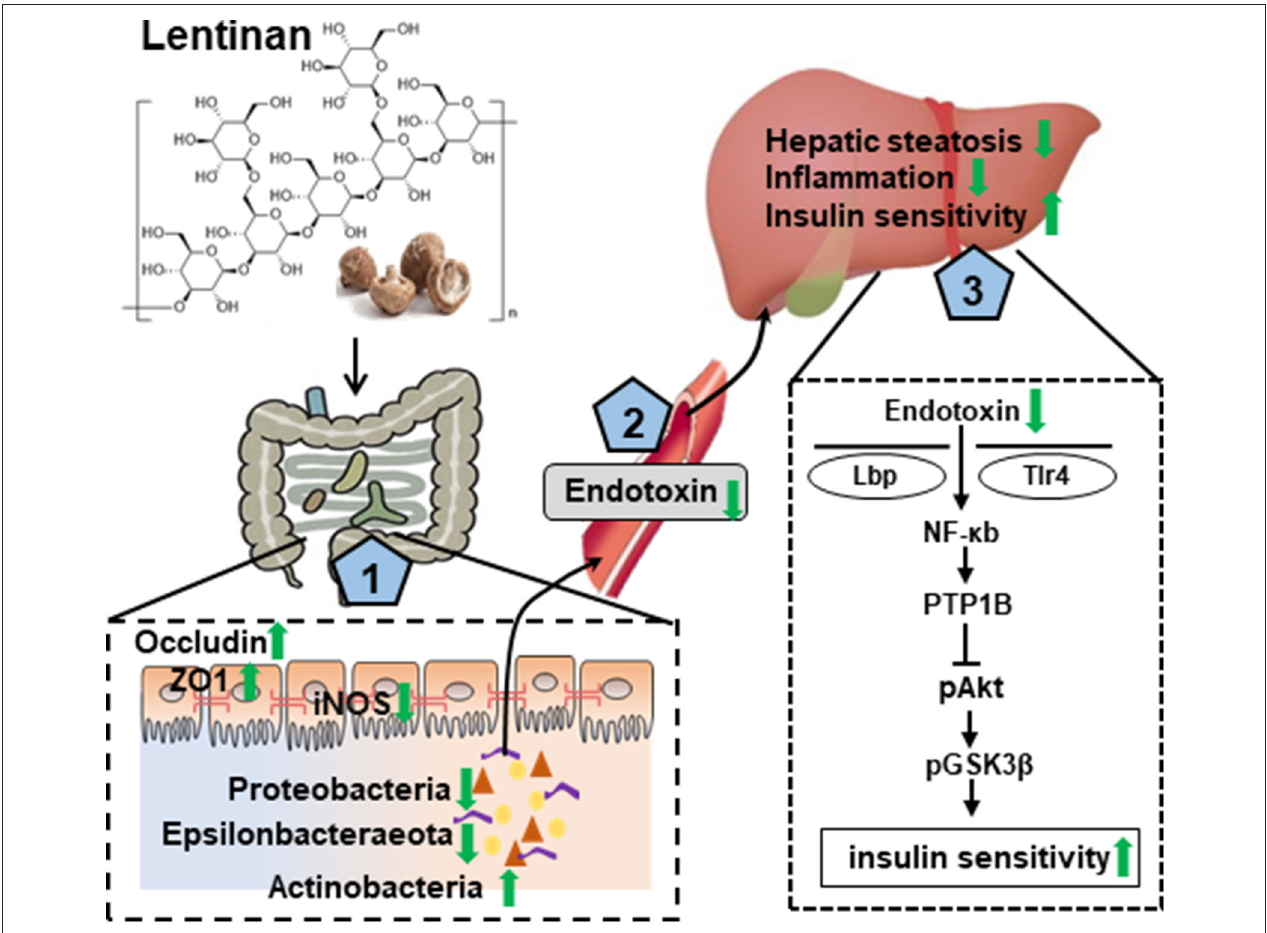
FIGURE 7 | Graphical summary of the protective effect of lentinan on the development of NAFLD via the gut–liver axis. Lentinan showed conservation of appropriate intestinal microbiota composition, resetting cellular redox balance (activation of antioxidants and inhibition of iNOS), and increasing tight junction proteins for gut epithelial integrity (1), which contribute to reduce endotoxin translocation into circulation and liver (2) and thereby to mitigate the adverse consequences of HF consumption, that is, hepatic steatosis and inflammation, and insulin resistance (3). Green arrows represent lentinan’s